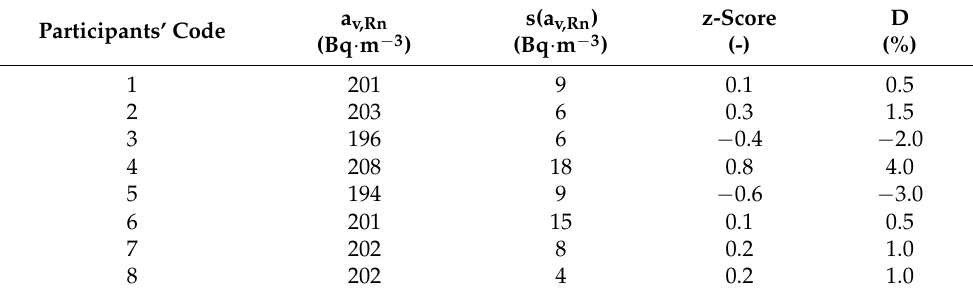
Table 3. Results for a level of radon activity concentration of 200 Bq·m −3.